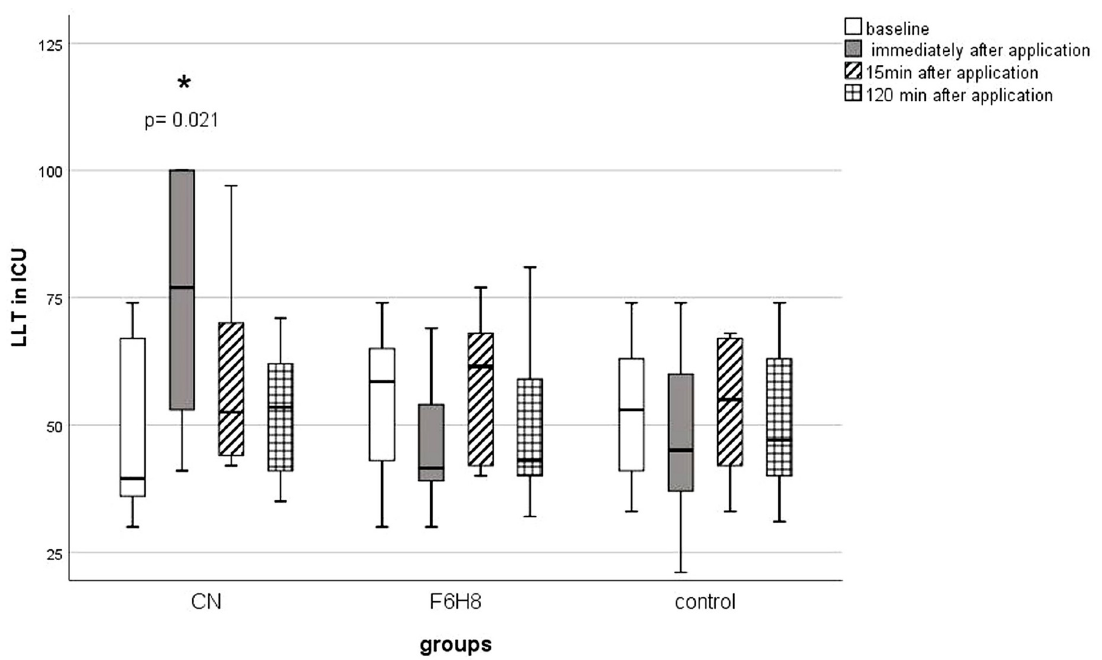
Fig 2. Lipid layer thickness (in ICU) at baseline and consecutive measurements. The measurement values up to 120 min after application were compared with the baseline using the Wilcoxon test. All p-values were adjusted for 3 comparisons according to the Bonferroni method. An asterisk with the corresponding p-value indicates a significant change compared to baseline measurement. ICU = Interferometric Colour Units; CN = cationic nanoemulsion; F6H8 =